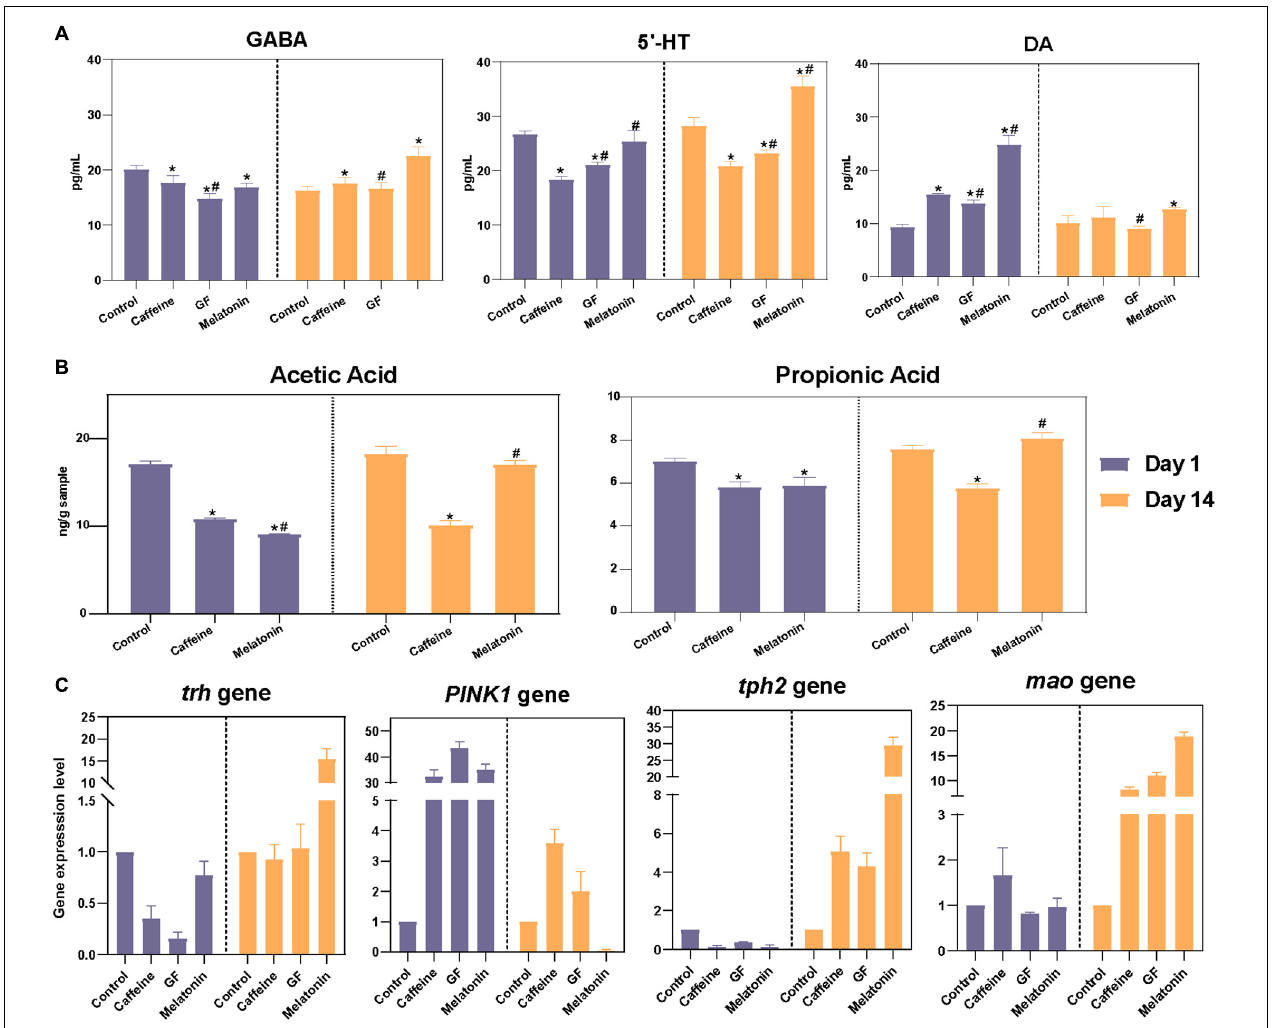
FIGURE 5 | Correlation analysis of neurotransmitter levels in validation experiments. (A) Further verification was performed using germ-free zebrafish, and the levels of neurotransmitters in the zebrafish brain, including DA, γ -GABA, and 5-HT, were detected on days 1 and 14 among the control, caffeine, GF, and melatonin groups. (B) GC-MS analysis of intestinal acetic acid and propionic acid concentrations in zebrafish and contents are expressed as nanograms per gram of intestine. (C) The zebrafish genes associated with DA ( PINK1 ), γ -GABA ( trh ), and 5-HT ( tph2 and mao ) secretion were selected and subjected to real-time PCR